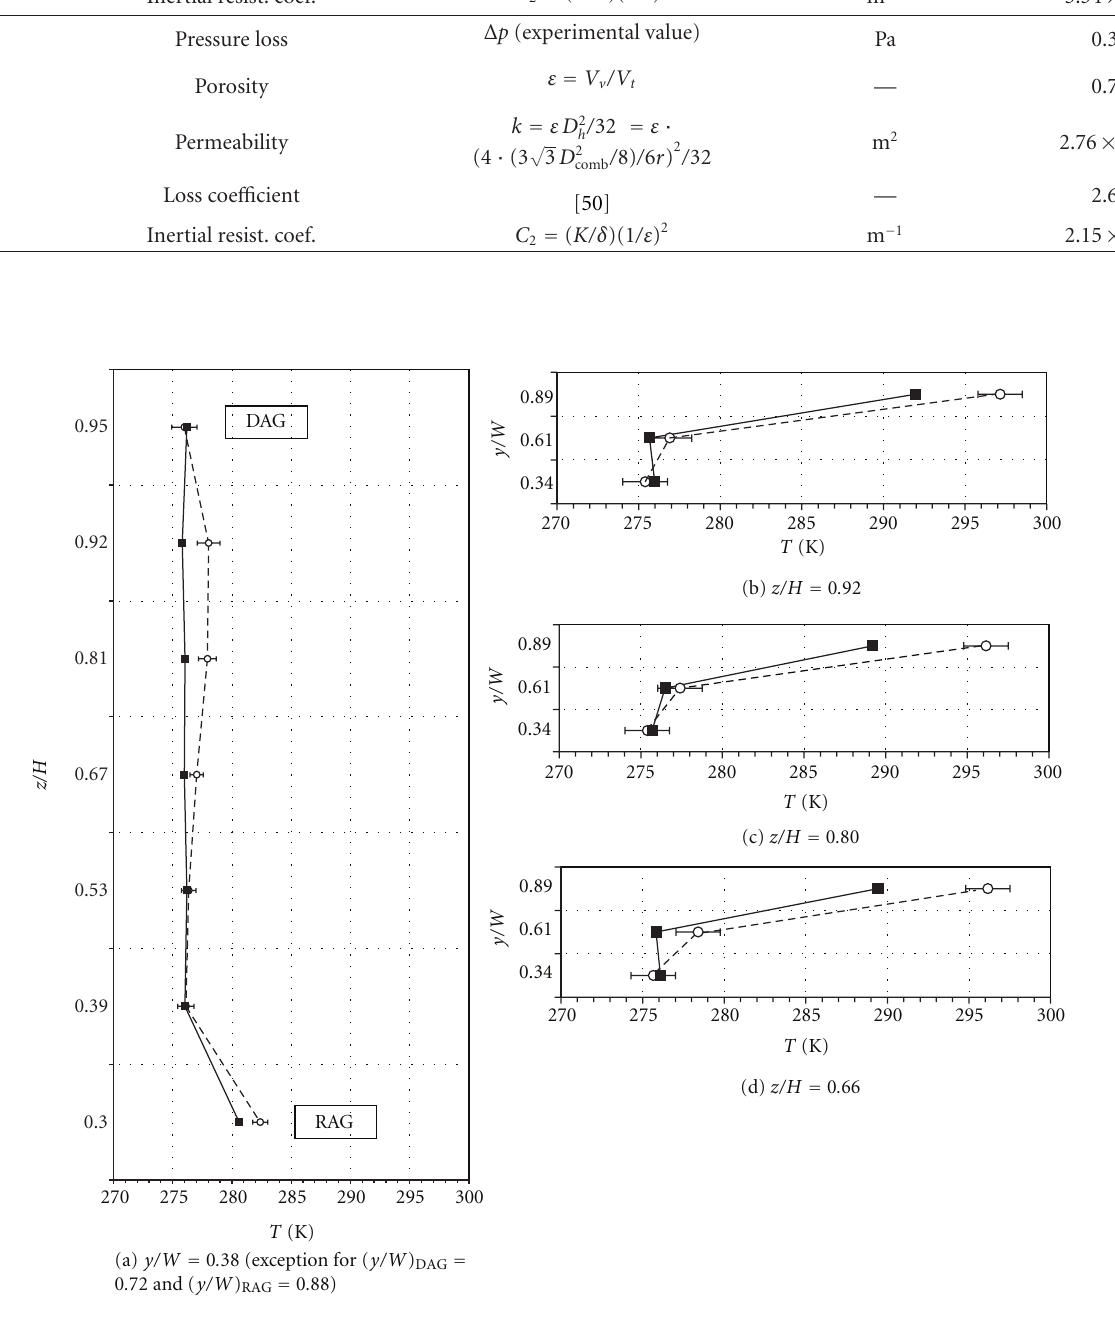
Figure 3: Comparative profiles of air temperature, T ( y / W , z / H ) (K) (see CSML in Figure 1(b)). (Legend: numerical: (cid:2) ; experimental: (cid:6)